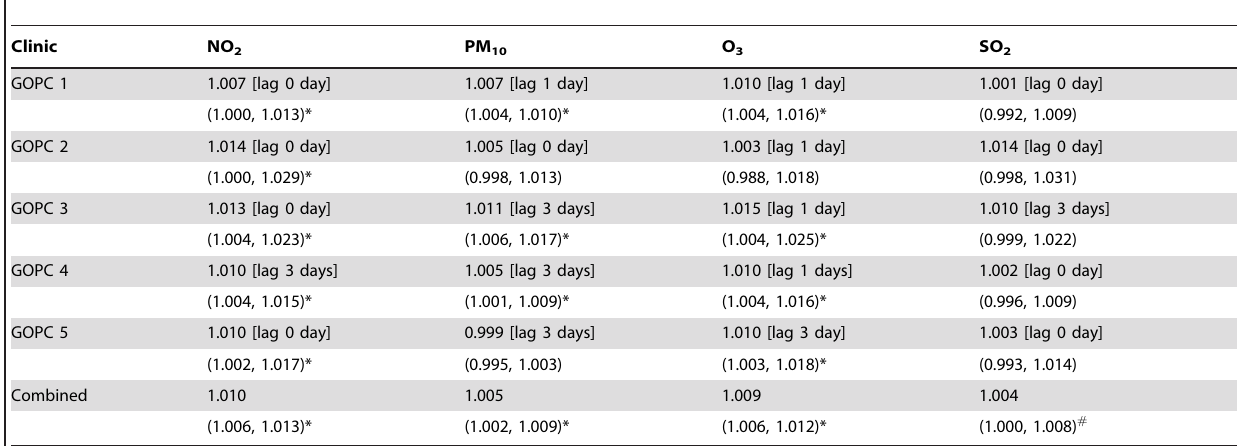
Table 4. Relative risks and 95% CI of the visits to five GOPCs for upper respiratory tract infections (URTIs), per 10 m g/m 3 increase in the concentration of air